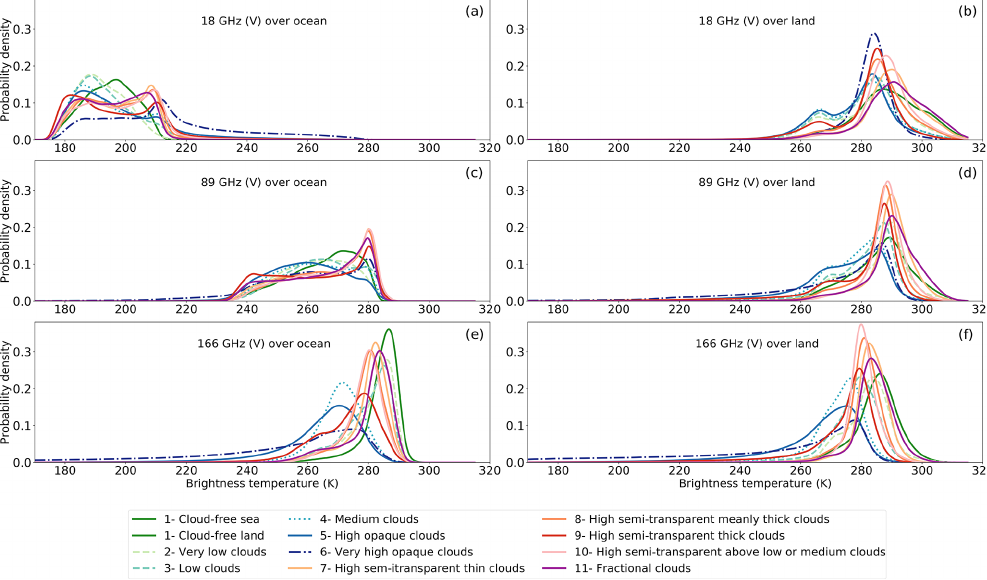
Figure 2. Probability distributions of the GMI-observed T bs for various cloud types at 18 (a, b) , 89 (c, d) , and 166GHz (e, f) for the vertical polarization over ocean (a, c, e) and land (b, d, f) from the filtered data